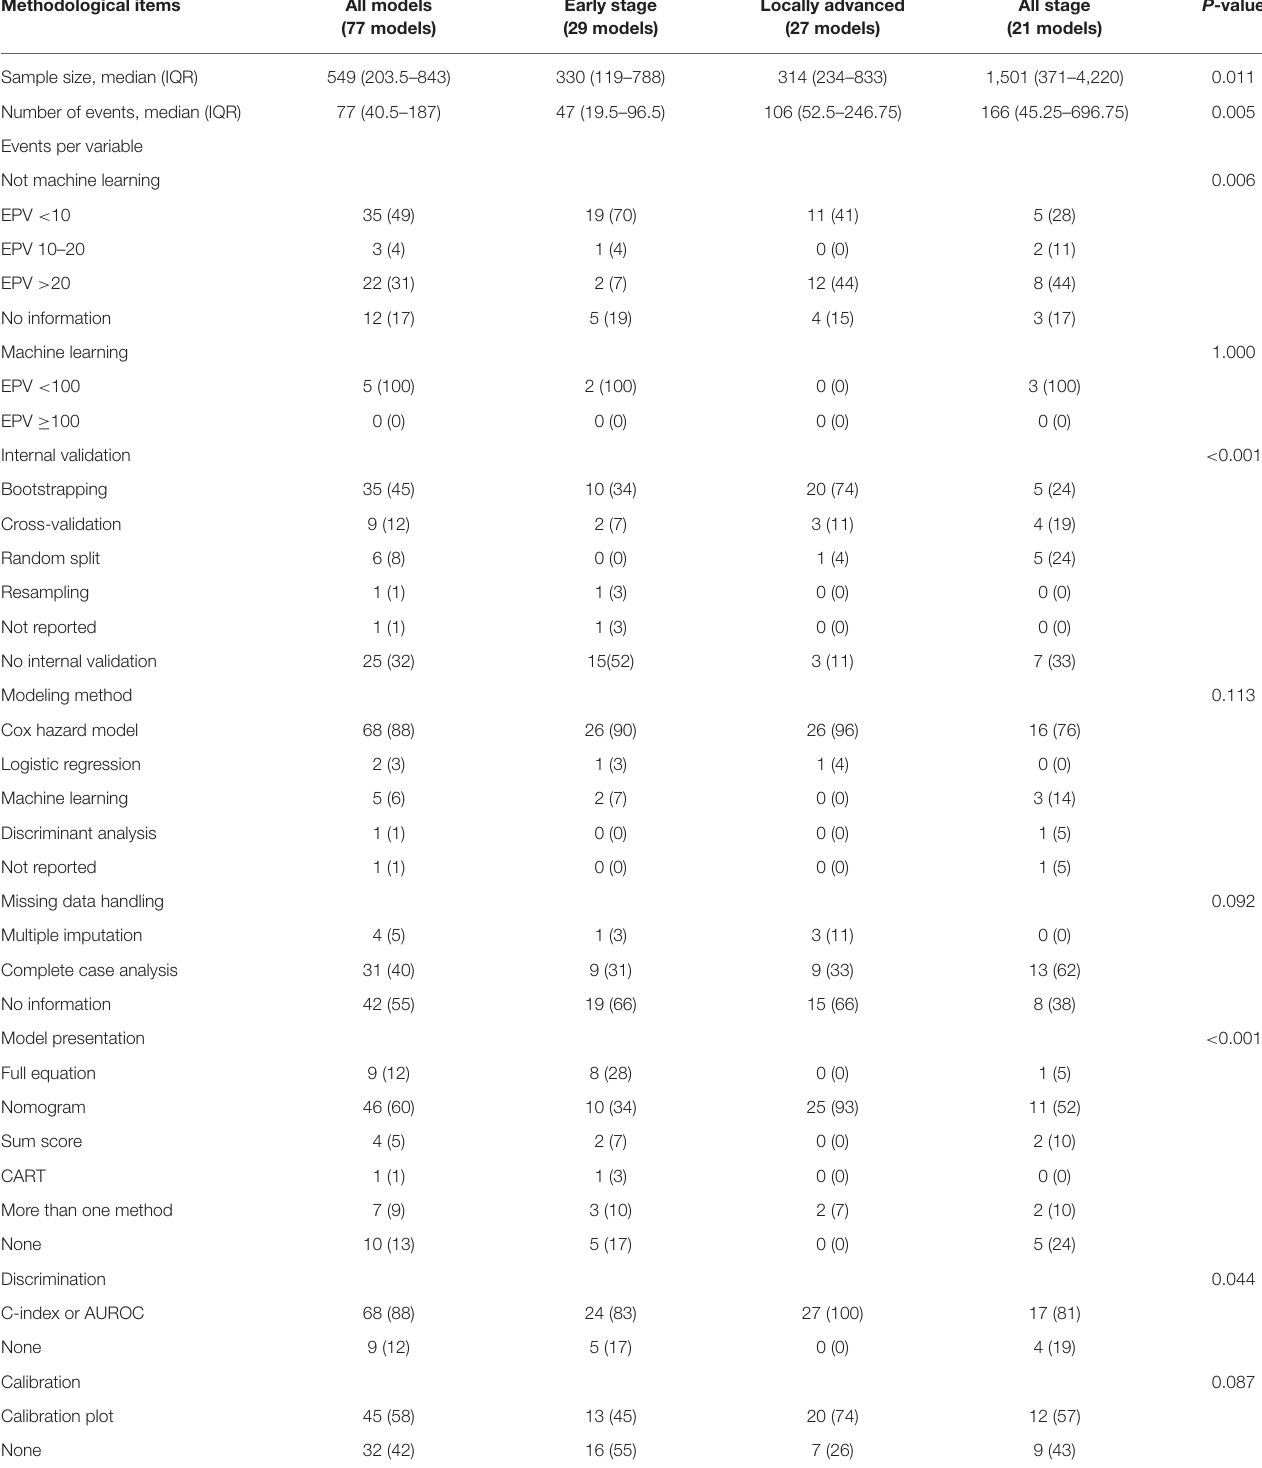
TABLE 2 | Methodological characteristics of the development of prognostic models for patients with cervical cancer by clinical